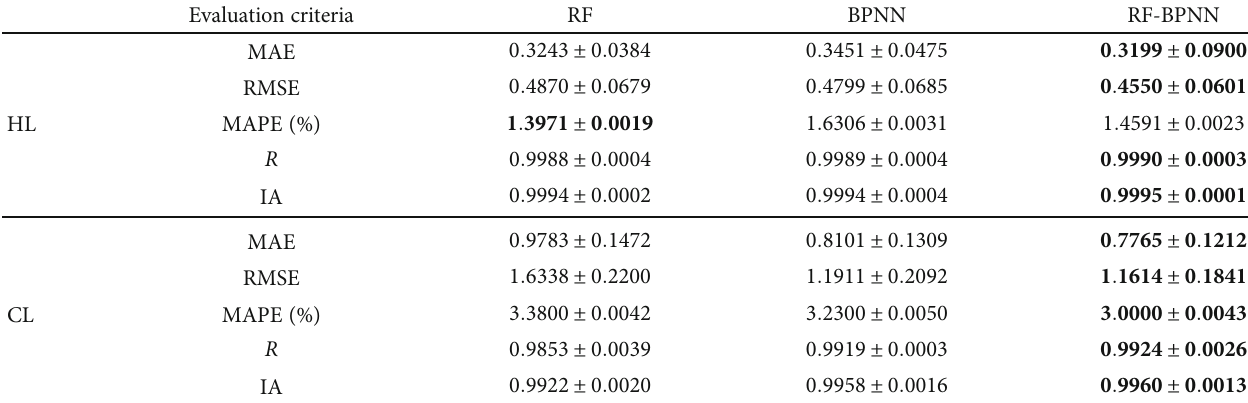
Table 4: Comparison of prediction results of RF, BPNN, and RF-BPNN models. Evaluation criteria